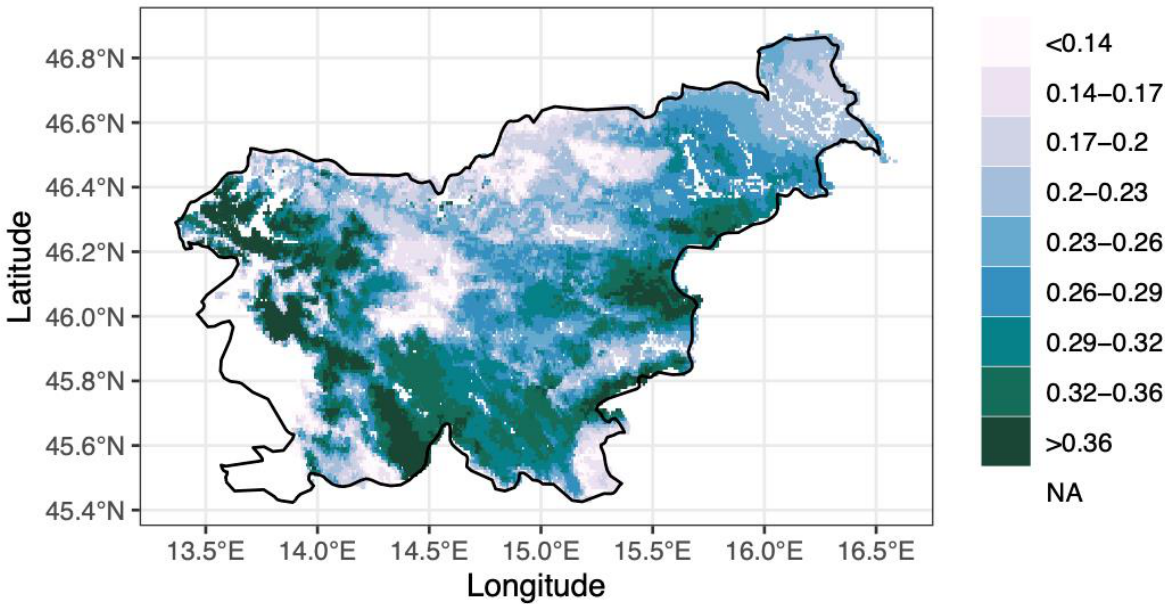
Figure 4. Potential dominance of beech trees in Slovenia. Darker colors represent a higher amount of potential dominance, while lighter colors represent a lower amount.